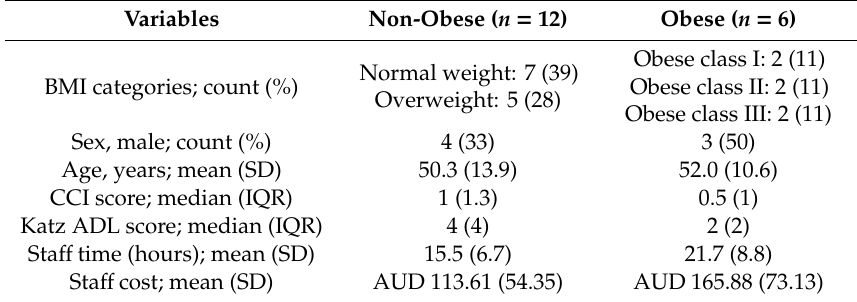
Table 4. Participant characteristics and sta ffi ng cost amongst those with and without